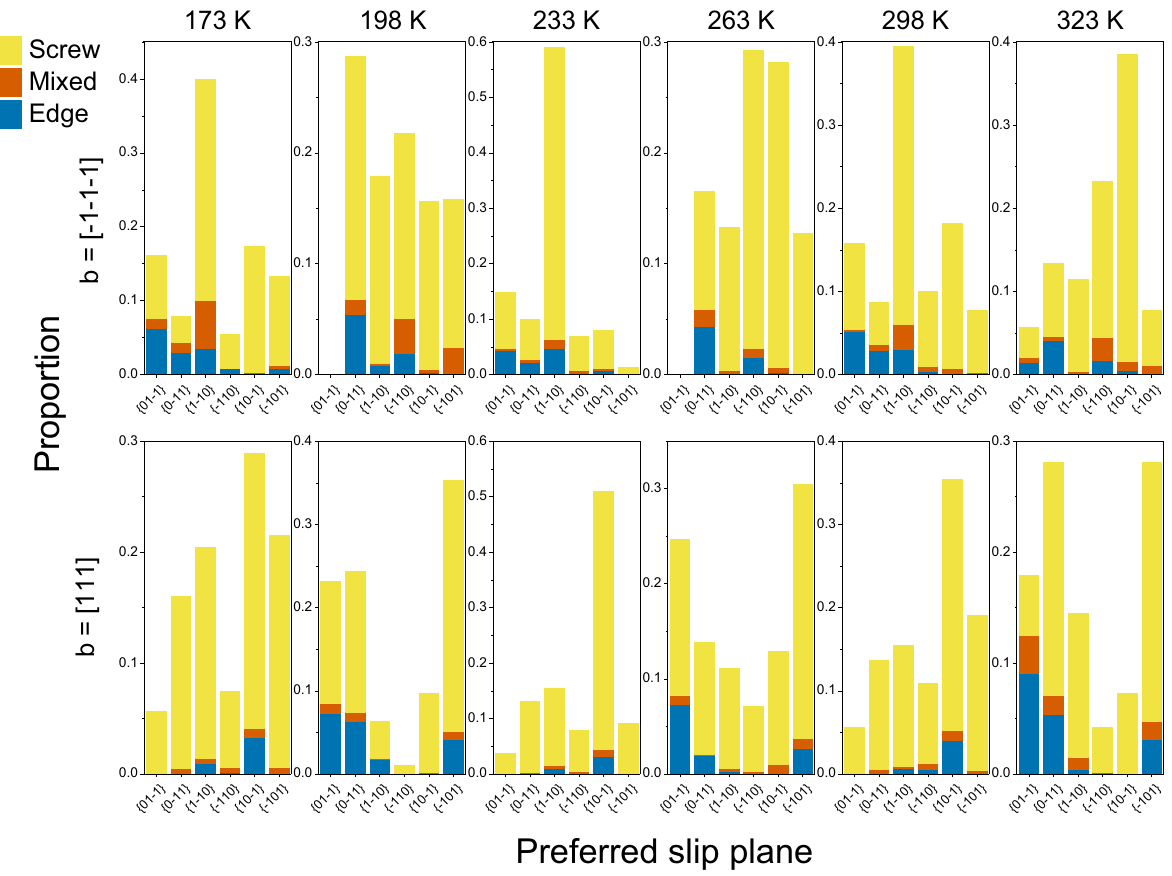
Fig. 5 Temperature-dependent fractions of dislocation types across slip systems. There is no clear trend as to which slip planes are preferentially activated for dislocation avalanches, as can be expected in bcc crystals. However, at all temperature ranges and regardless of the preferred slip plane, the vast majority of dislocations identi fi ed to participate in avalanche behavior are screw dislocations.